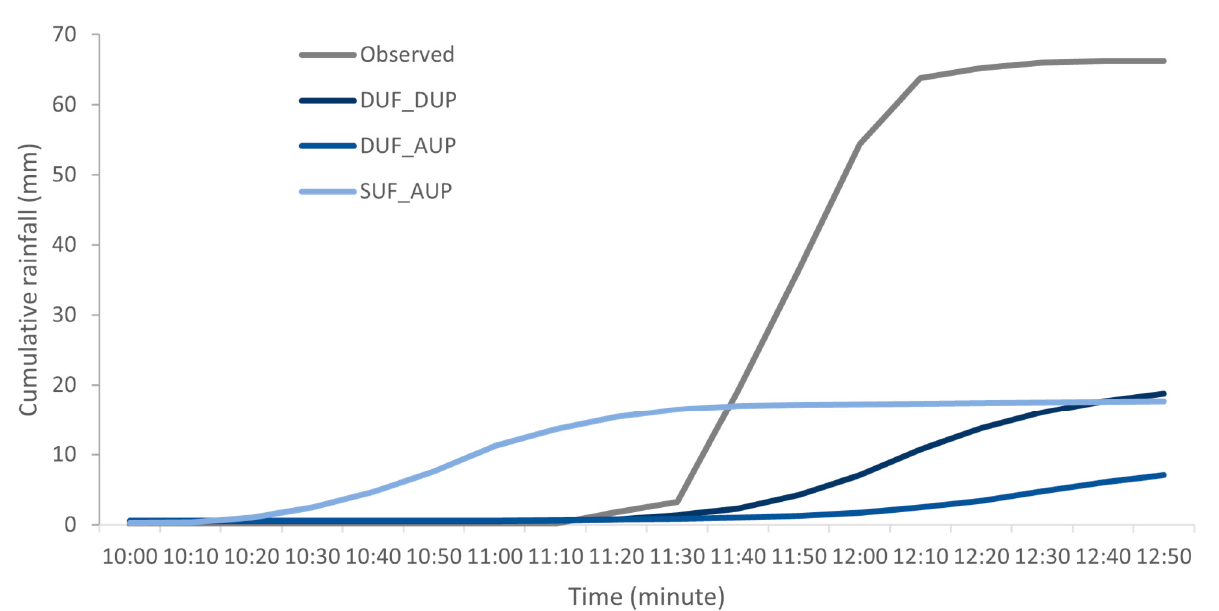
Figure 5. Cumulative rainfall curves for observation and three WRF simulations at the AWS location. Gridcell-rainfall curves for the DUF_DUP, DUF_AUP, and SUF_AUP simulations are shown in three-hour time windows from 10:00 to 12:50, equivalent to the observation at the AWS location. The 2 h rainfall analysis focuses on the duration between 11:00 to 12:50, where the maximum peak intensity was captured by AWS observation.